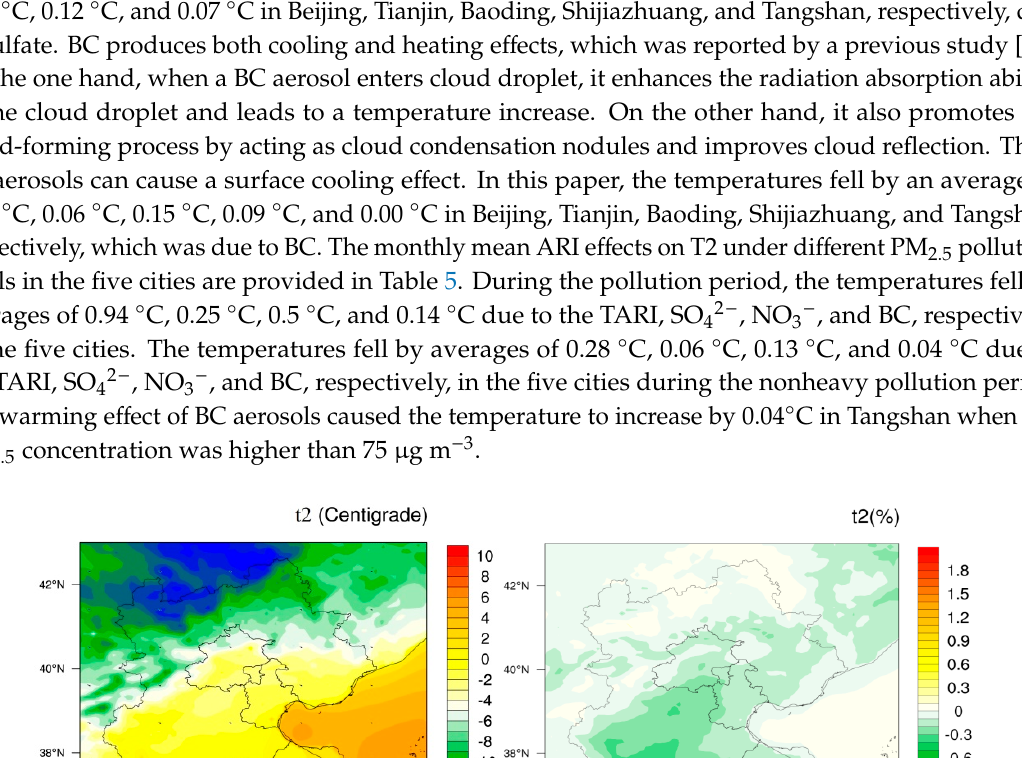
Table 5. The effect on T2 under different PM 2.5 pollution levels.